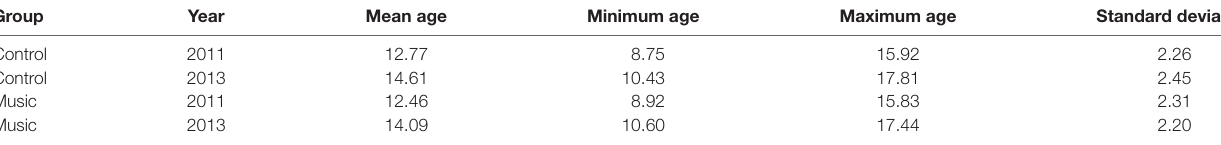
TABLE 2 | Ages of participants in the Music and Control groups per measurement year for the Trail-Making Test.